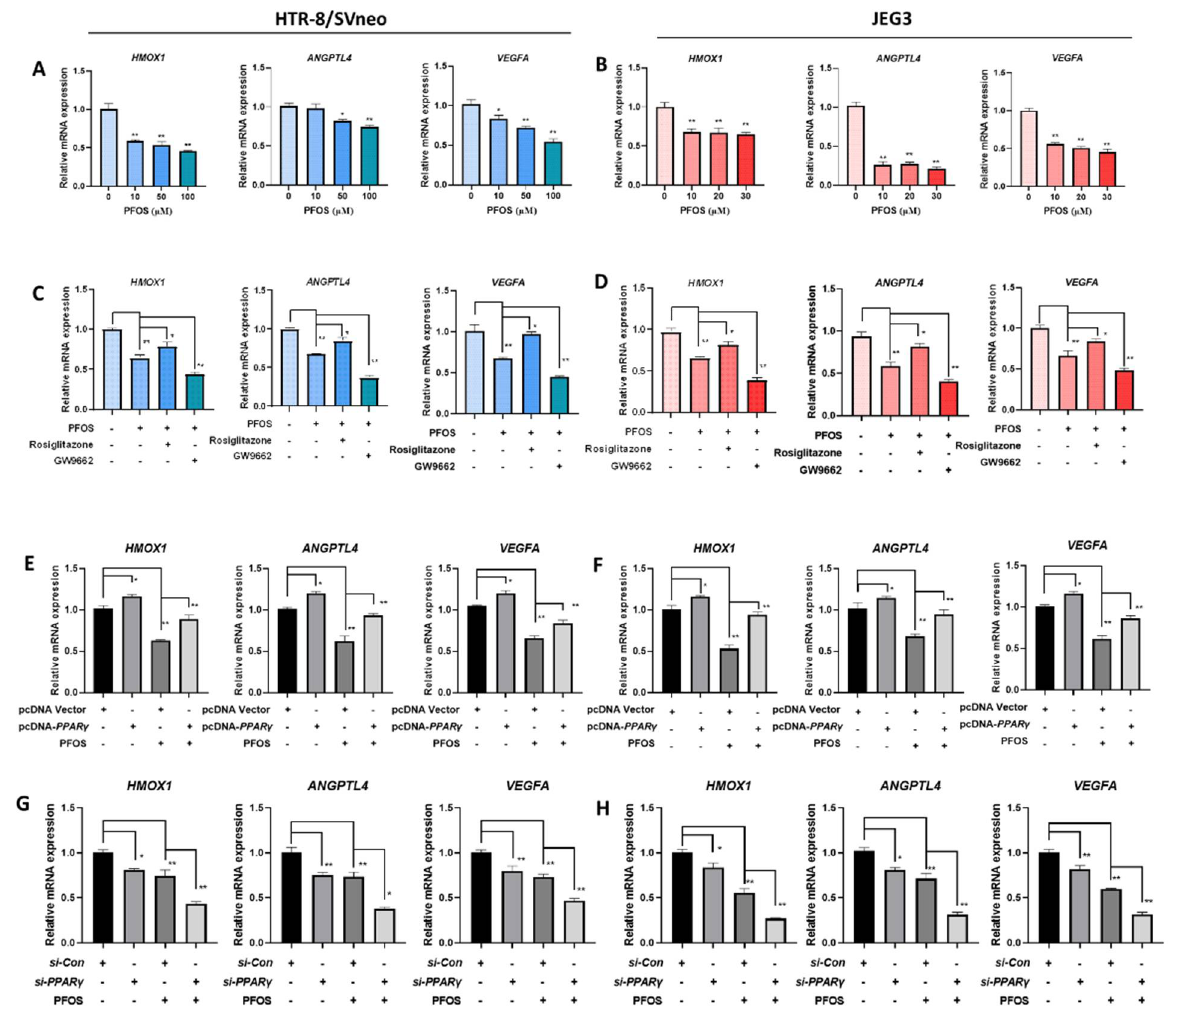
Figure 4. Effect of PFOS on PPAR γ target genes associated with proliferation and angiogenesis in vitro. The mRNA expression was analyzed by RT-PCR in HTR-8/SVneo and JEG-3 cells were exposed to PFOS for 24 h ( A , B ), in the absence or presence of rosiglitazone and GW9662 ( C , D ), with PPAR γ overexpression ( E , F ) and knocking down ( G , H ) in HTR-8/SVneo and JEG-3 cells. The data are shown as the means ± S.E.M. * p < 0.05; ** p < 0.01; compared with the indicated group, n =